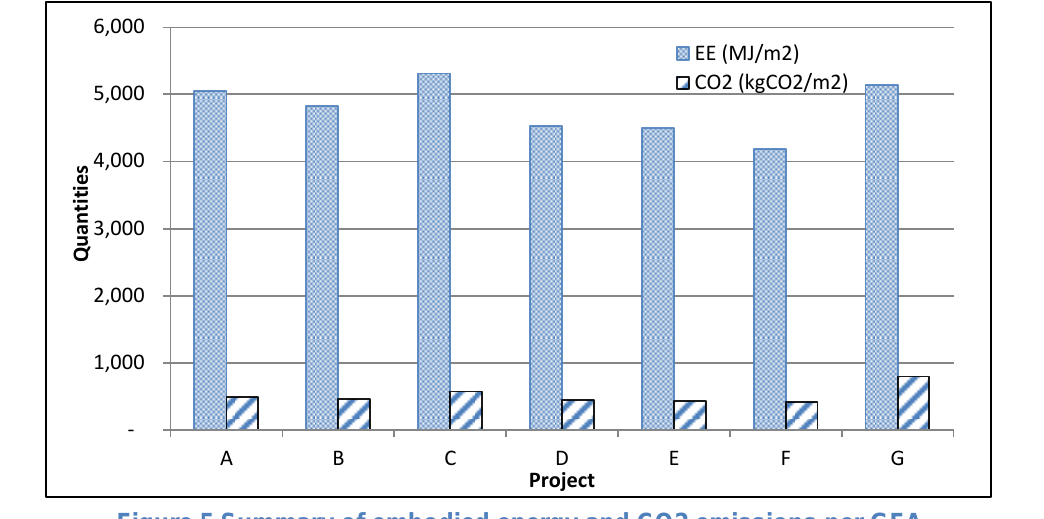
Figure 5 Summary of embodied energy and CO2 emissions per